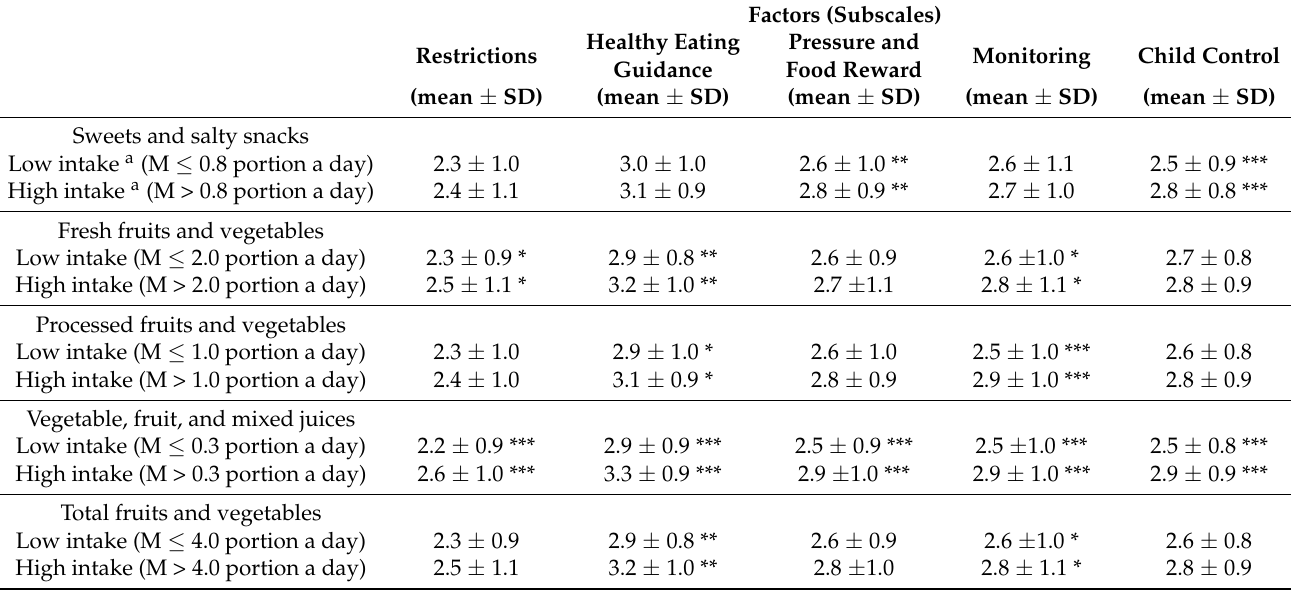
Table 5. Discriminant capability for the Adults’ Memories of Feeding in Childhood using selected food products